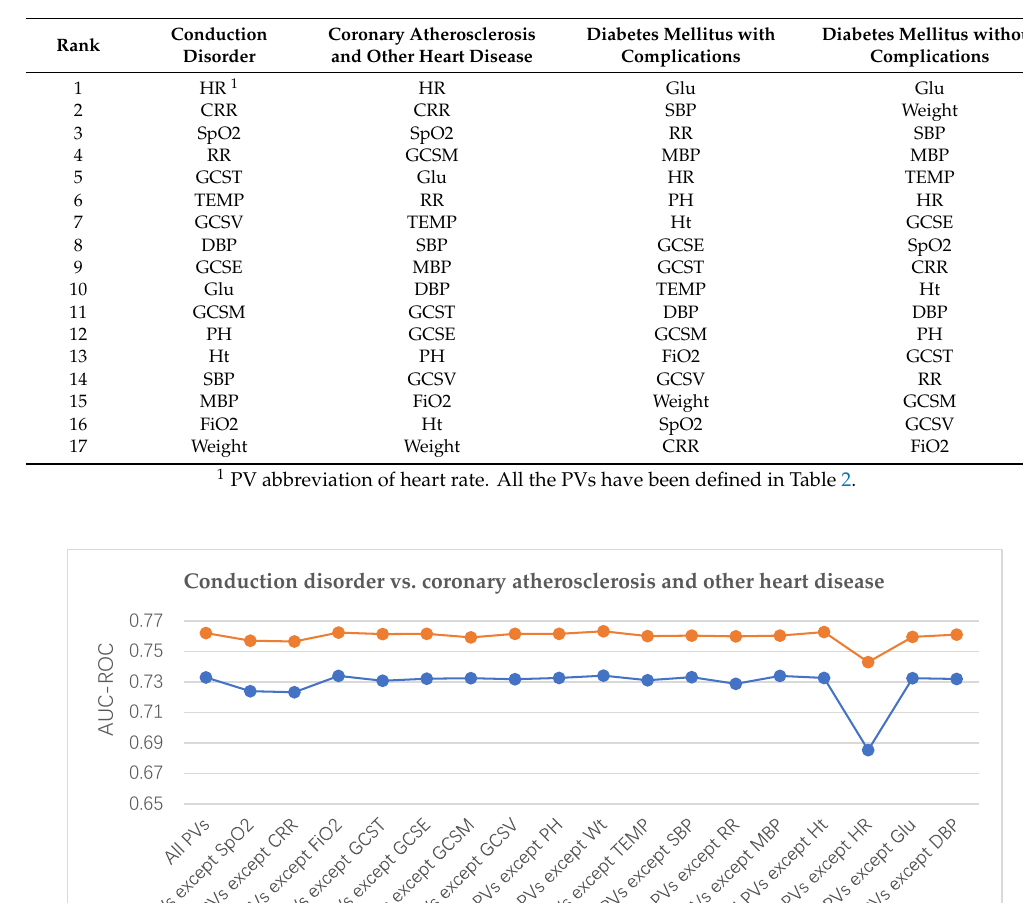
Table 3. Examples of ranking the importance of PVs for di ff erent diseases.